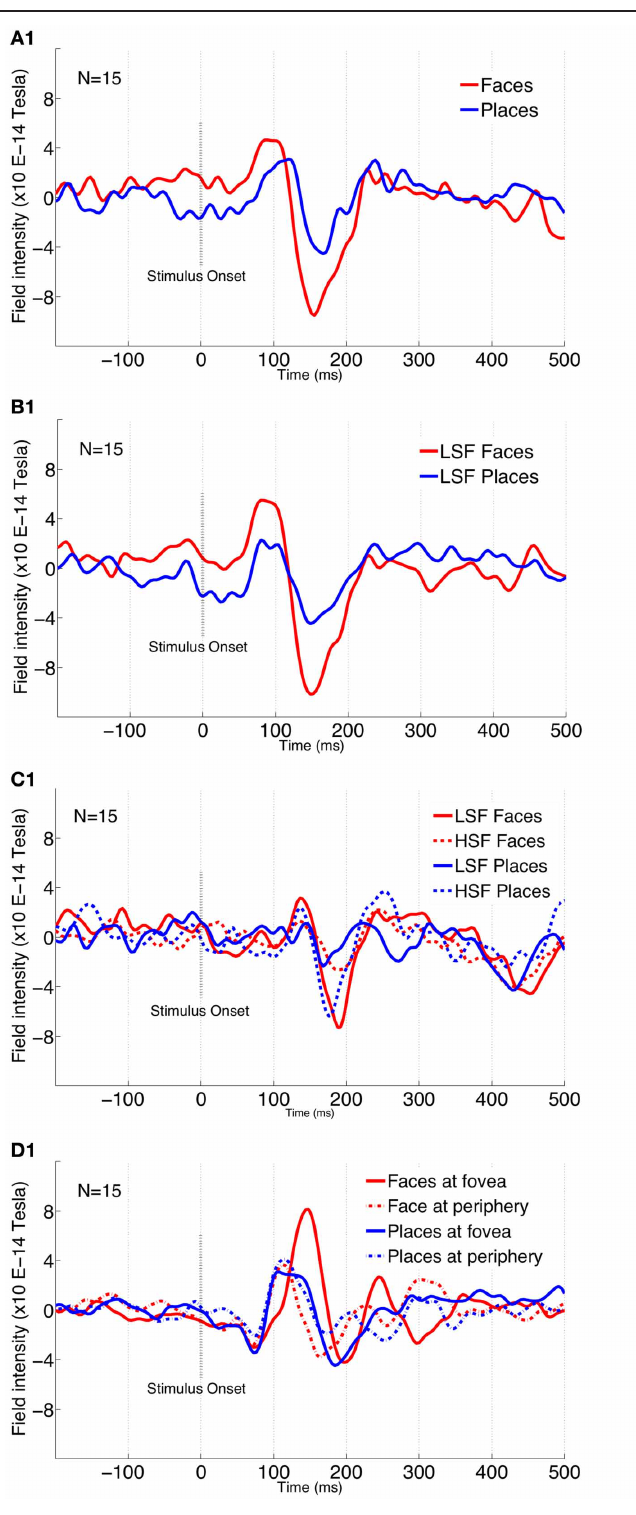
stimulus onset. In 2 plots, solid black line shows the mean difference while the dotted purple and green lines represent 95% CI in positive and negative directions, respectively. (A1) Significant amplitudes for face and place stimuli.